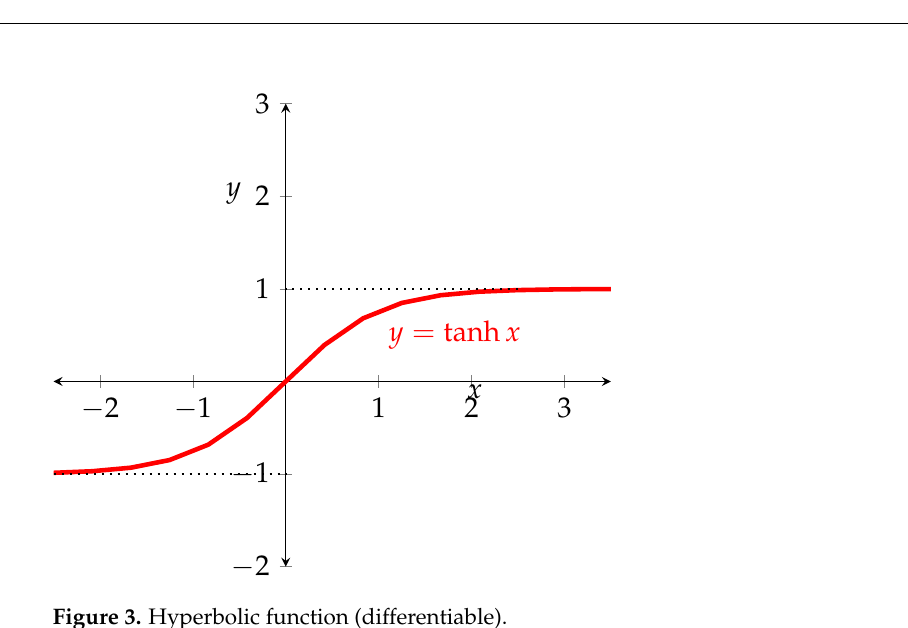
Figure 3. Hyperbolic function